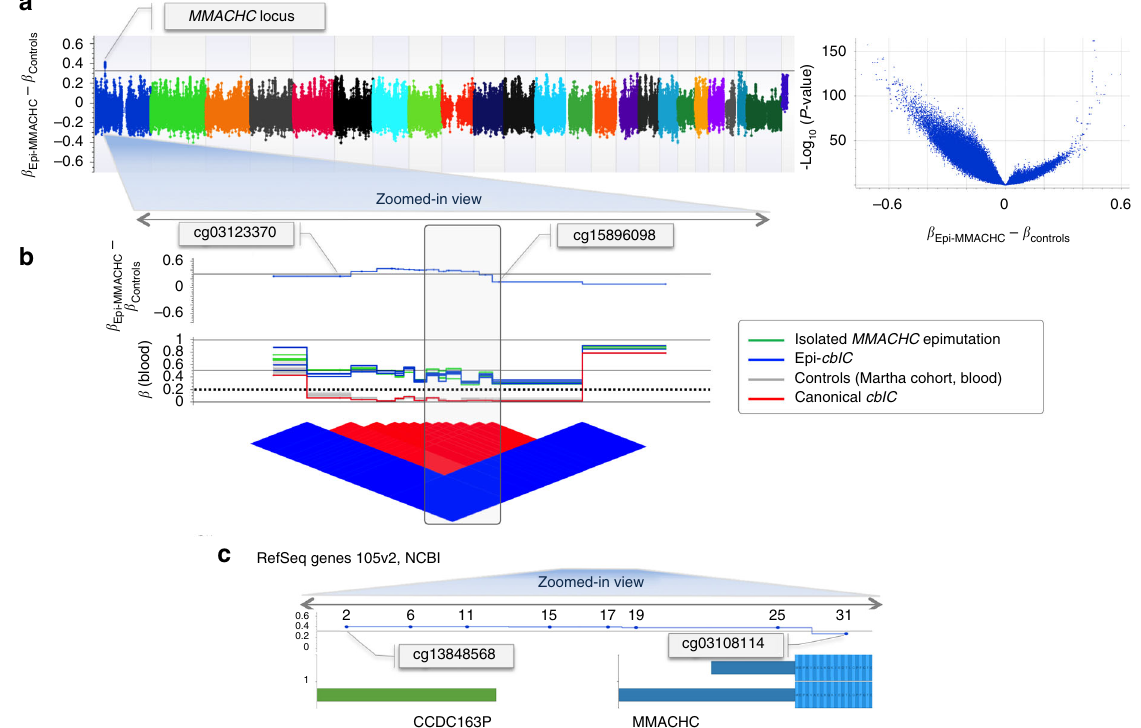
Fig. 3 Epigenome-wide analyses con fi rm the presence of the epimutation in genomic DNA and sperm. a Epi-Manhattan plot for the differences between β values in the epi- MMACHC subjects and controls ( β Epi-MMACHC – β Controls ). The horizontal line indicates a difference of 0.3; the volcano plot shows the relationship between ( β Epi-MMACHC – β Controls ) and − log 10 ( P -value) for the t -test. b Enlarged view of the MMACHC locus; β values of the CpG probes in the MMACHC locus and the epi-linkage disequilibrium plot reporting the matrix relationship between the CpG probes based on the blood samples. The dotted line corresponds to a β value threshold of 0.2, below which the CpG probe was considered to be fully unmethylated. c Genomic position of the MMACHC locus according to RefSeq Genes 105v2, NCBI